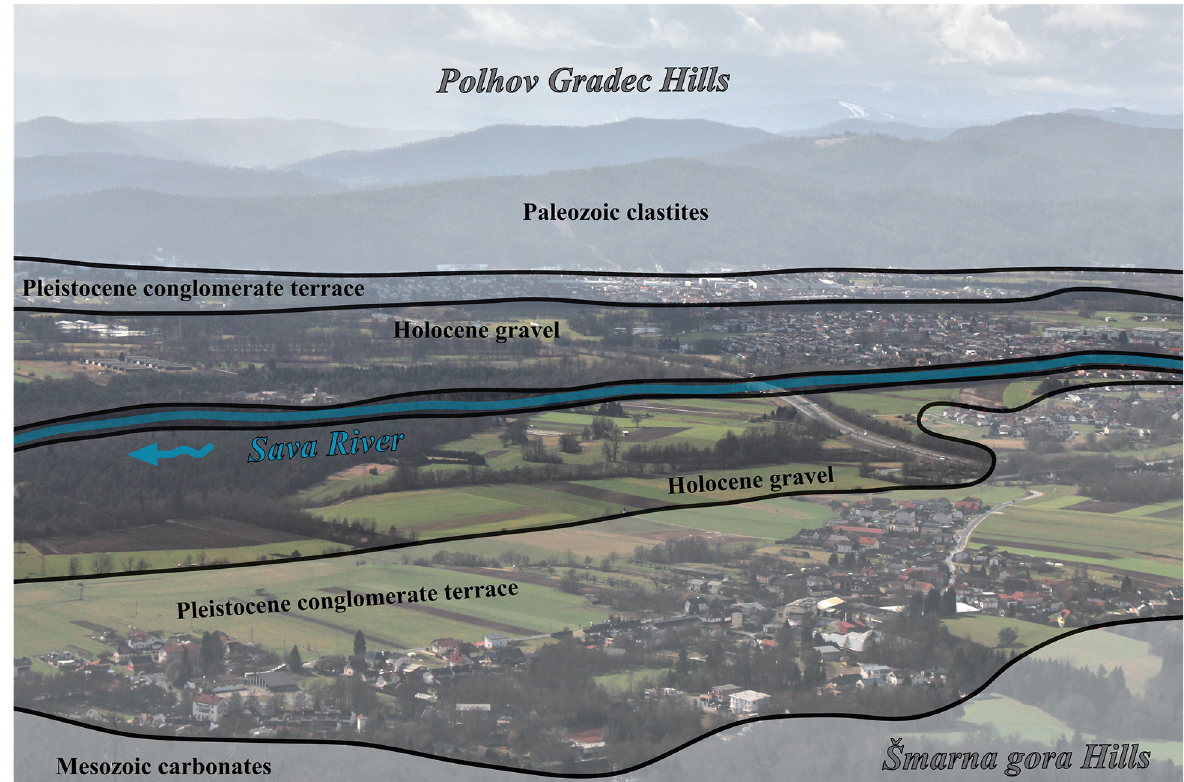
Fig. 6. System of river terraces in the northwest part of the Ljubljana Plain (photo: M.